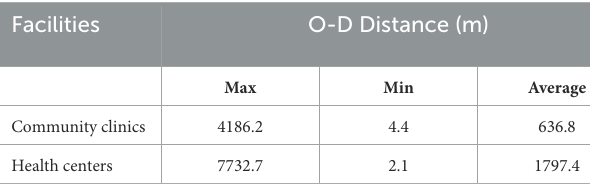
TABLE 1 Results of the Origin-Destination matrix